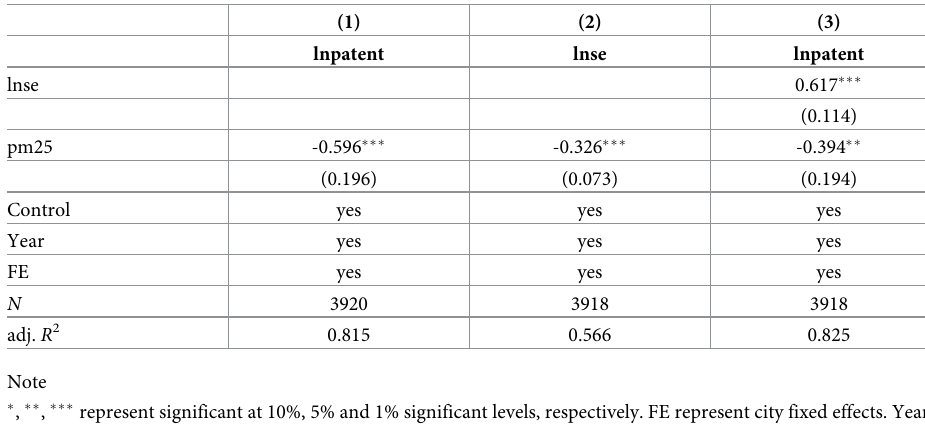
Table 12. Baseline